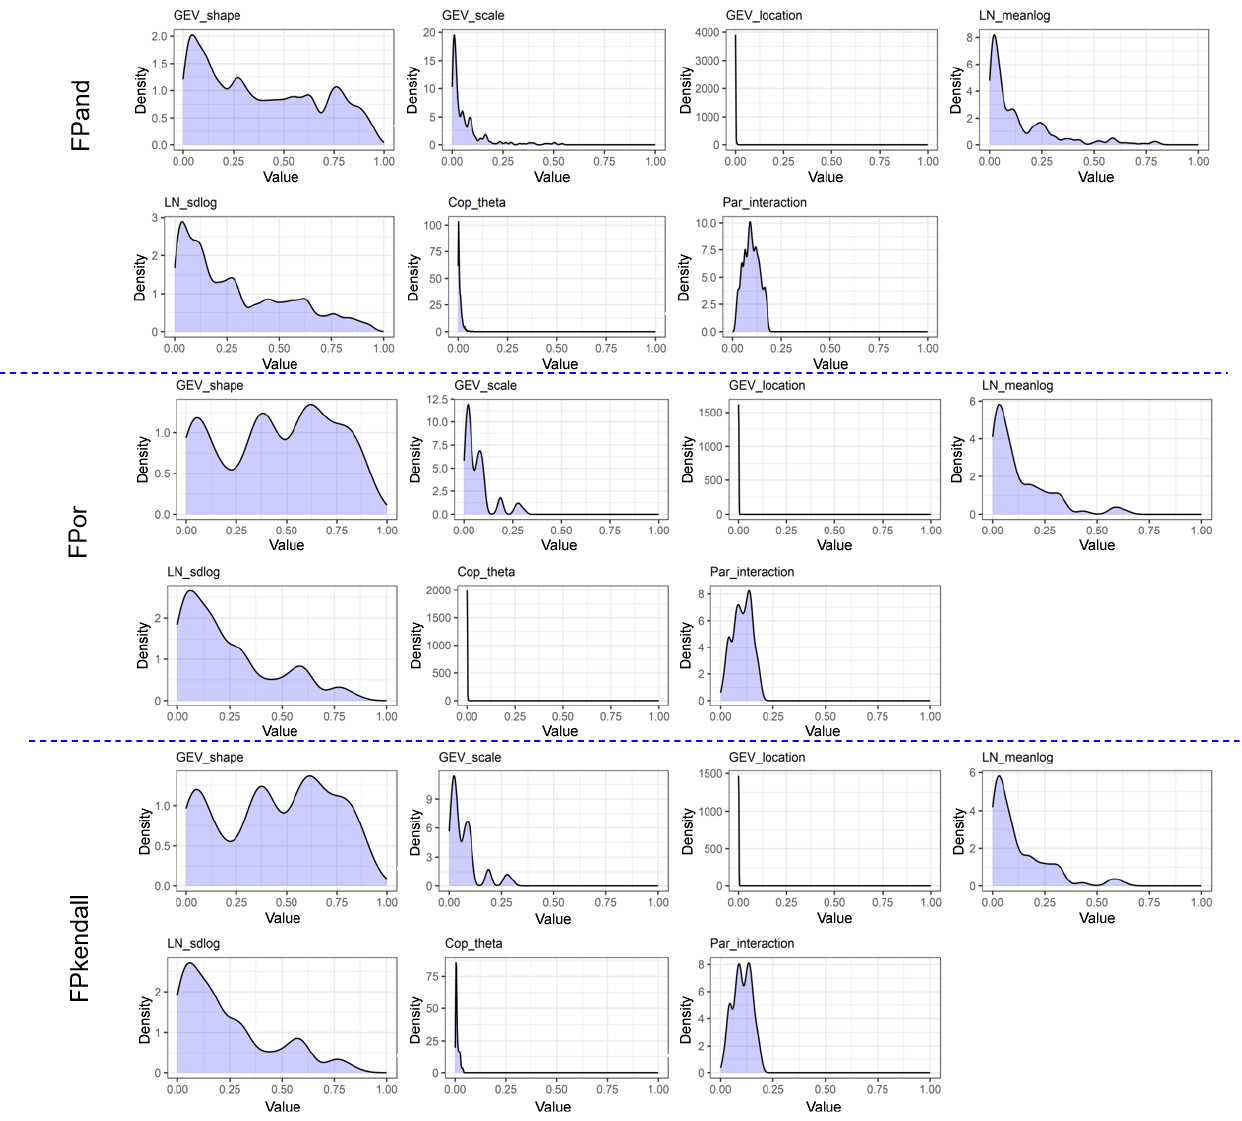
Figure 10. Variation of parameters’ contributions for different risk inferences at the Zhangjiashan station for a design standard of 200 years and a service time of 30